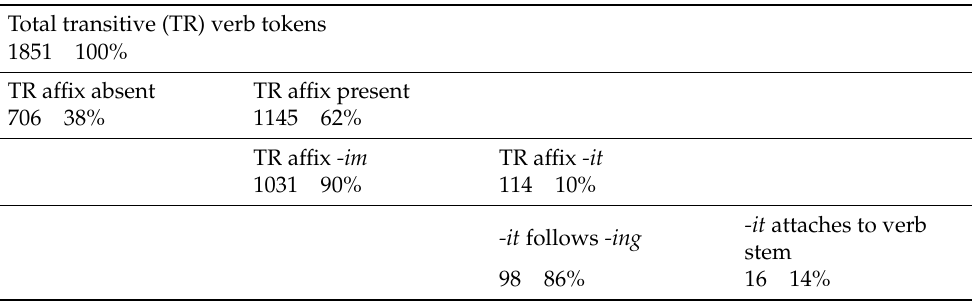
Table 4. Numbers of tokens and percentages of types of transitive